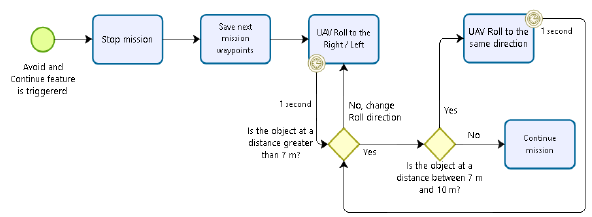
Figure 3. “Avoid and Continue” mode flow